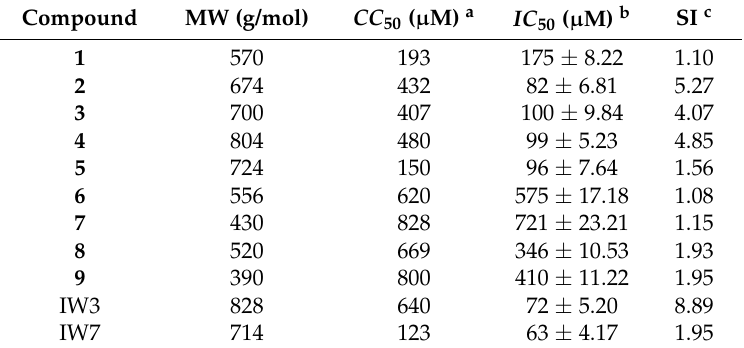
a Compound concentration required to reduce cell viability by 50%; b Compound concentration